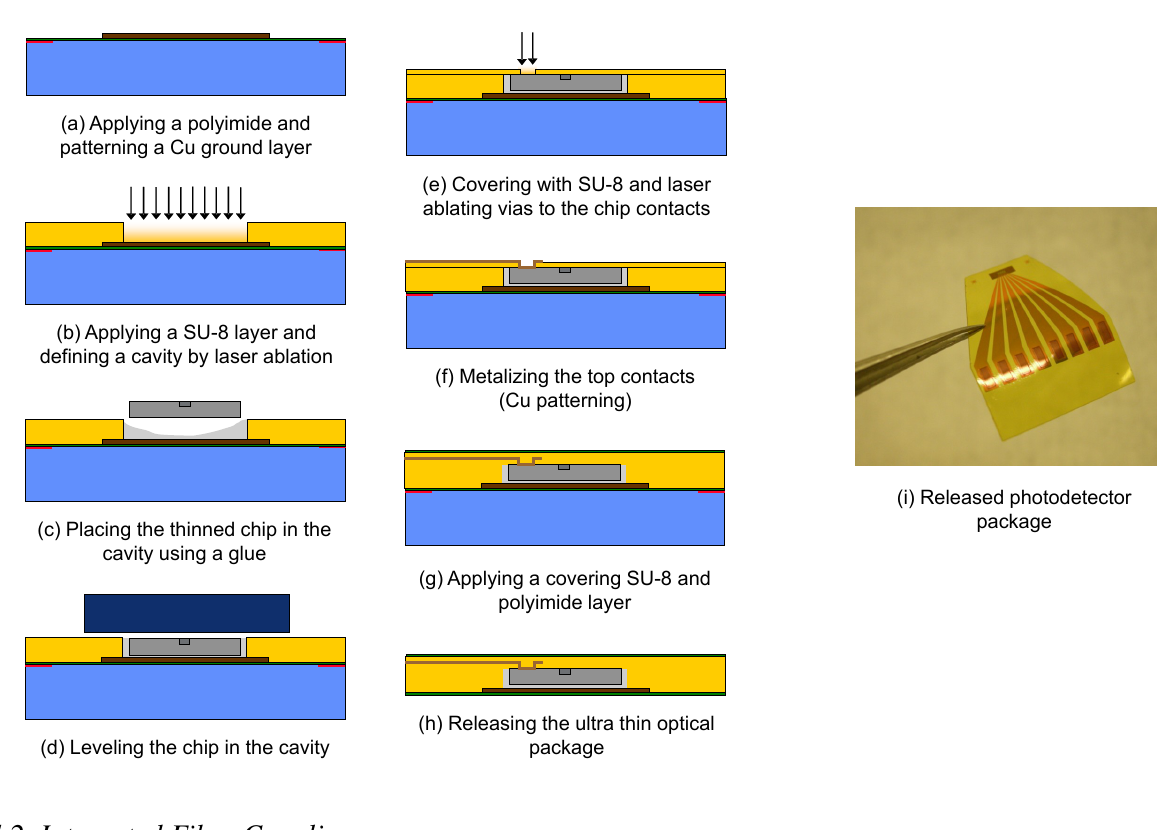
Figure 8. Chip package integration process